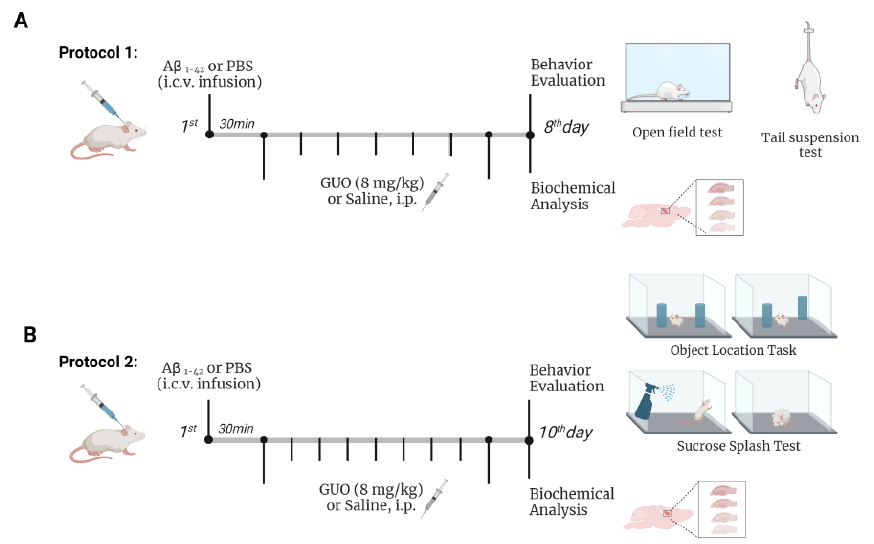
Figure 1. Overview of experimental protocols for behavioural and biochemical analysis in mice